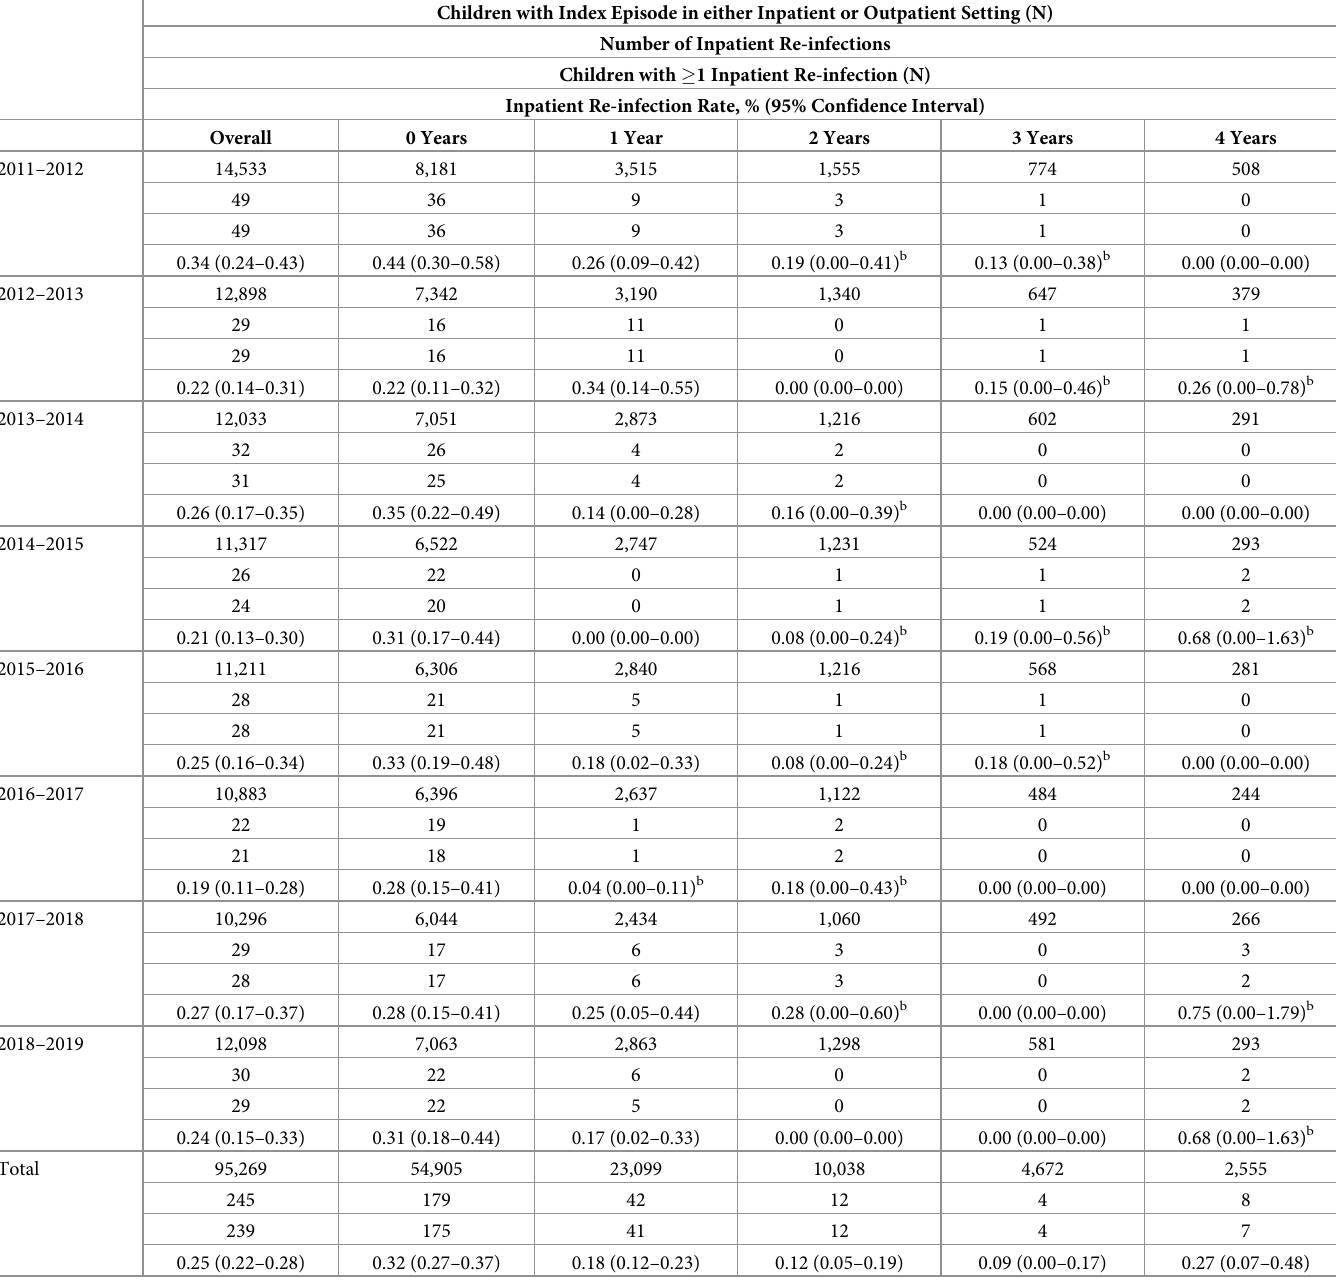
Table 1. Annual inpatient respiratory syncytial virus re-infection rate among commercially-insured children 0–4 years with an index inpatient or outpatient epi- sode in the same year, 2011–2019 a . Children with Index Episode in either Inpatient or Outpatient Setting (N) Number of Inpatient Re-infections Children with � 1 Inpatient Re-infection (N) Inpatient Re-infection Rate, % (95% Confidence